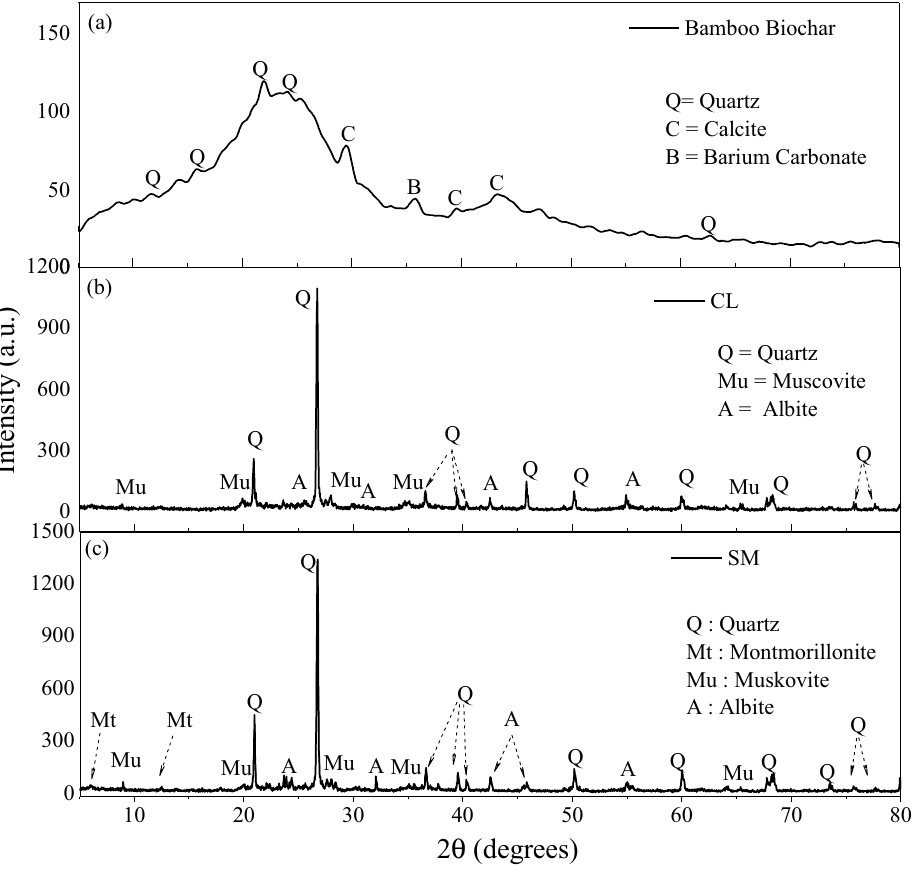
Figure 3. X-ray diffraction analysis of pure ( a ) bamboo biochar, ( b ) CL and (c) SM soil in powder